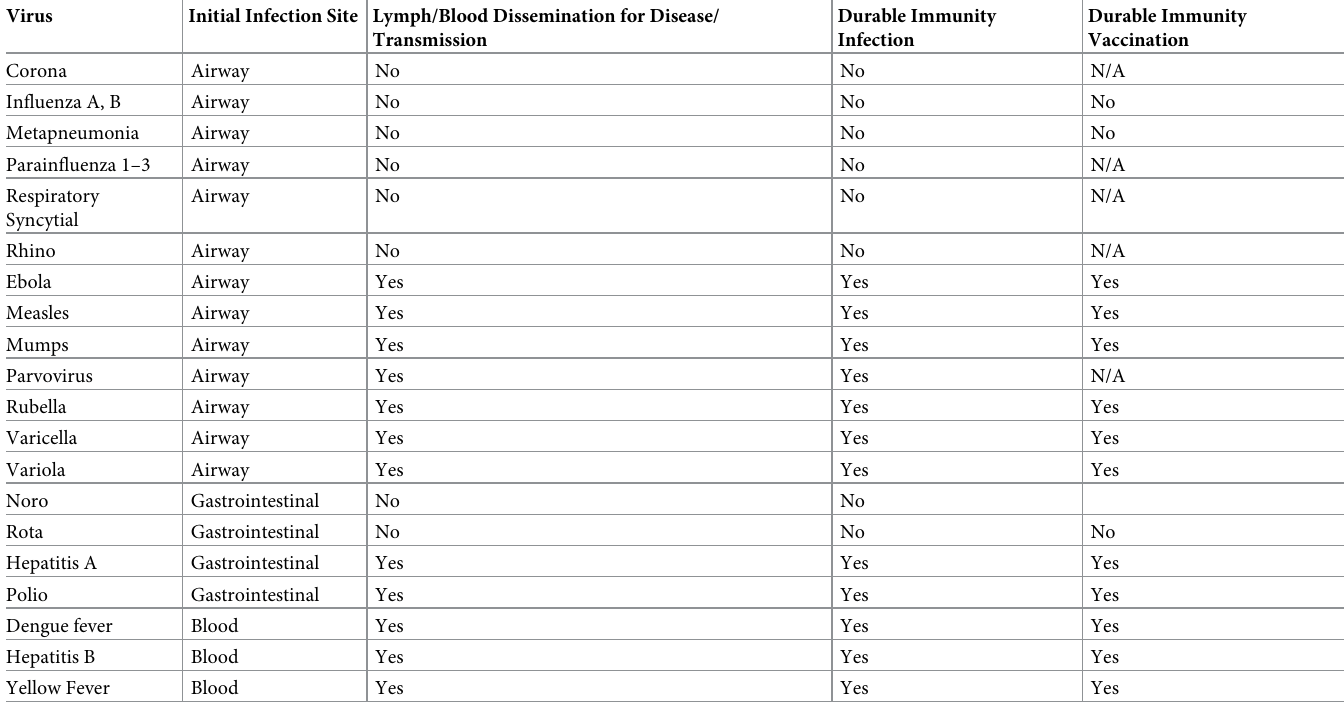
Table 1. Characteristics of infection and immunity for human viruses. Virus Initial Infection Site Lymph/Blood Dissemination for Disease/